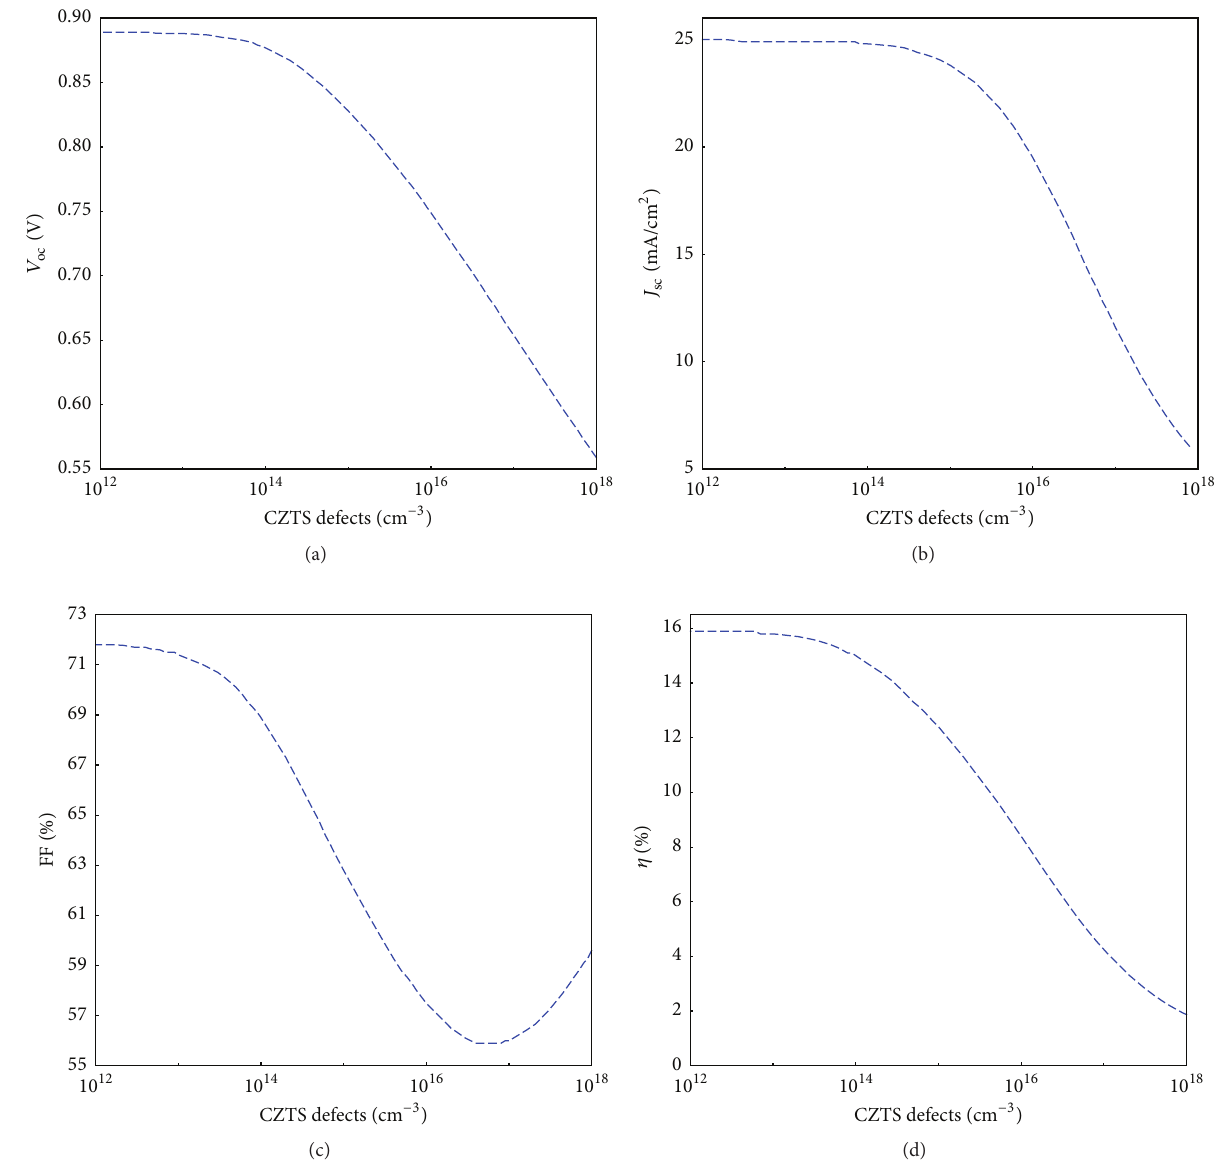
Figure 8: The simulation of defect density effects on the CZTS solar cell performance